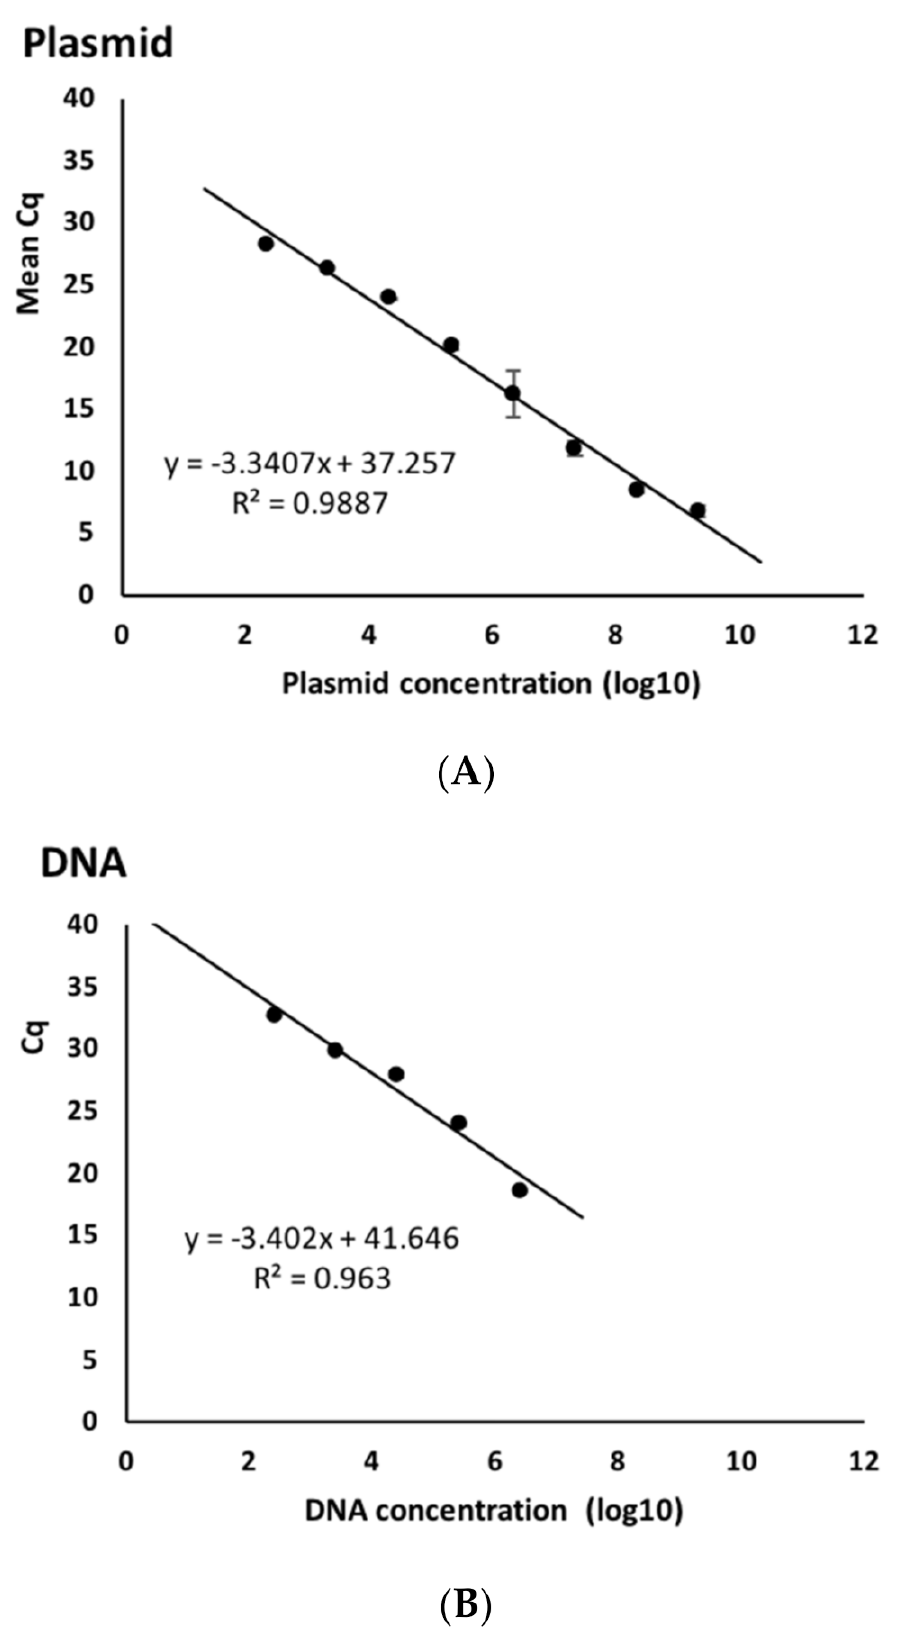
Figure 11. Standard curves obtained for dilutions of plasmid ( A ) and genomic ( B )